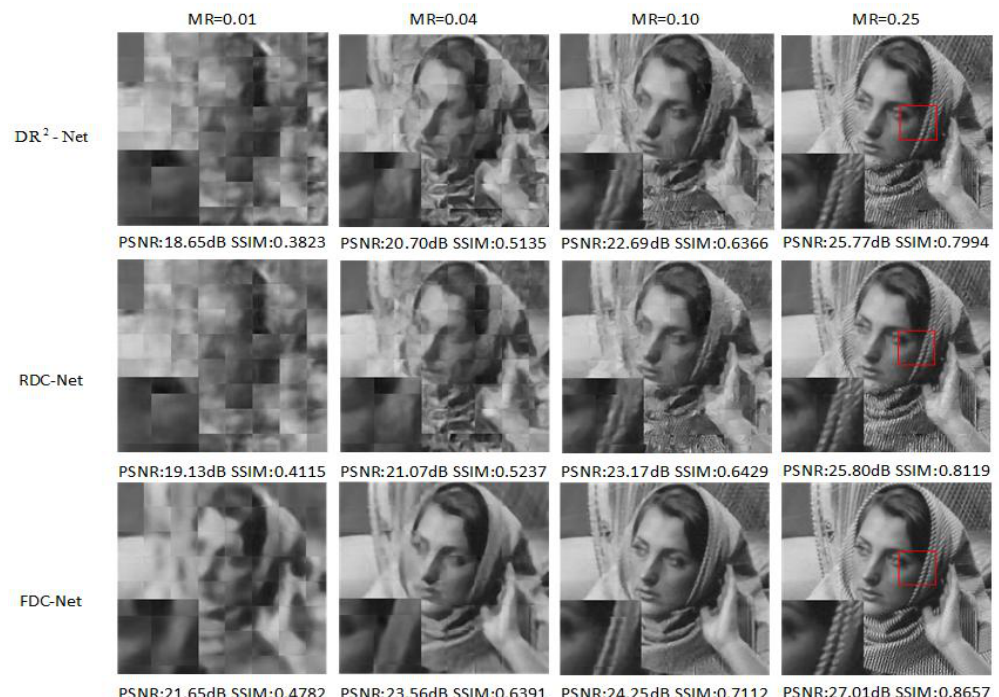
Figure 3. Barbara image reconstruction results from different networks. We can obviously find that two proposed networks obtain the excellent reconstruction performance and FDC-Net has better visual effects than RDC-Net, DR 2 -Net.